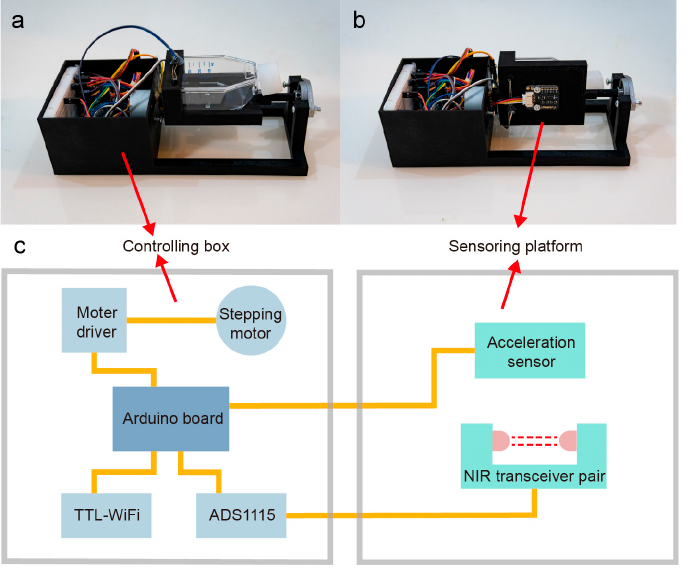
Figure 1. Design of a rocking microbioreactor. ( a ) Front view with the T25 flask in place. ( b ) Bottom view of the sensing platform, showing the acceleration sensor. ( c ) Connection diagram of electronic components.